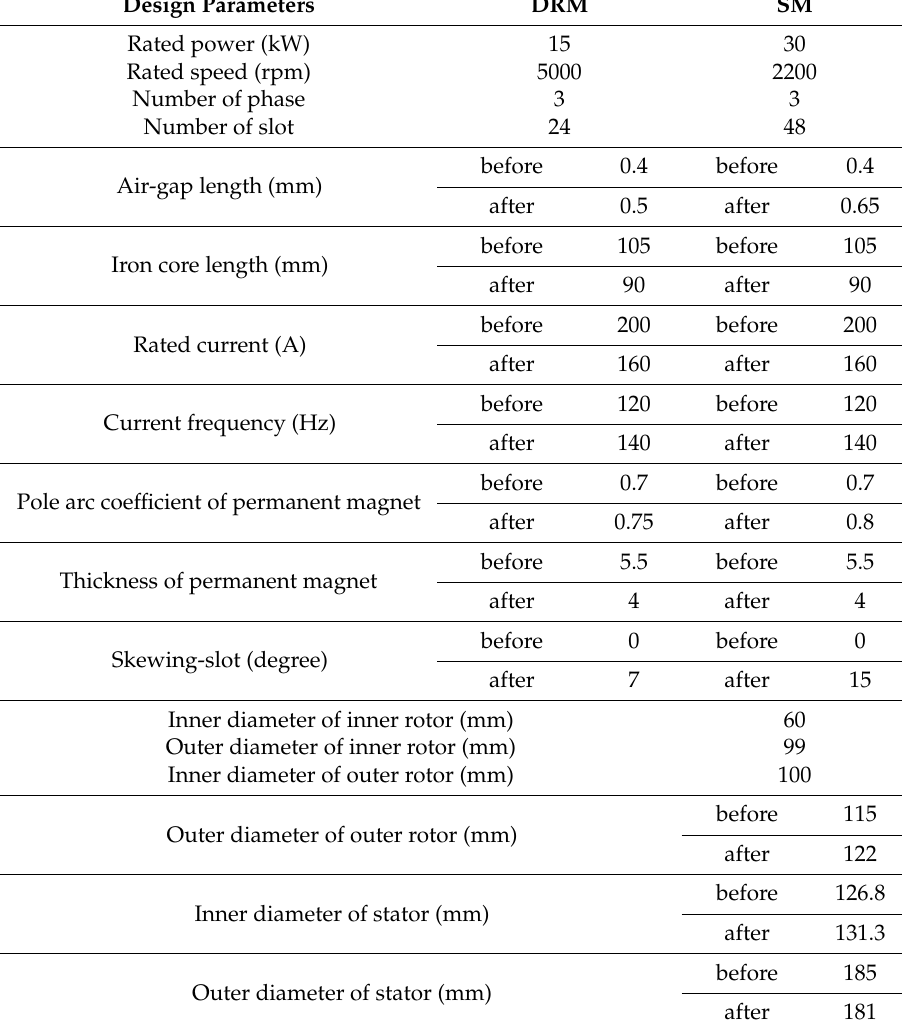
Table 1. Design parameters of CSPM